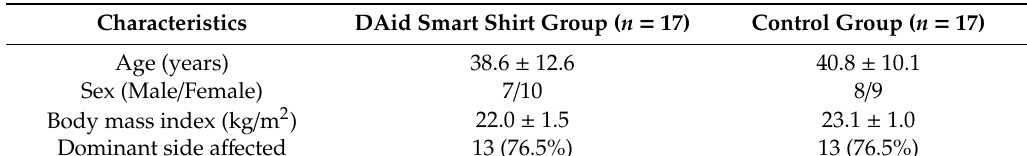
Table 1. Characteristics of participants.